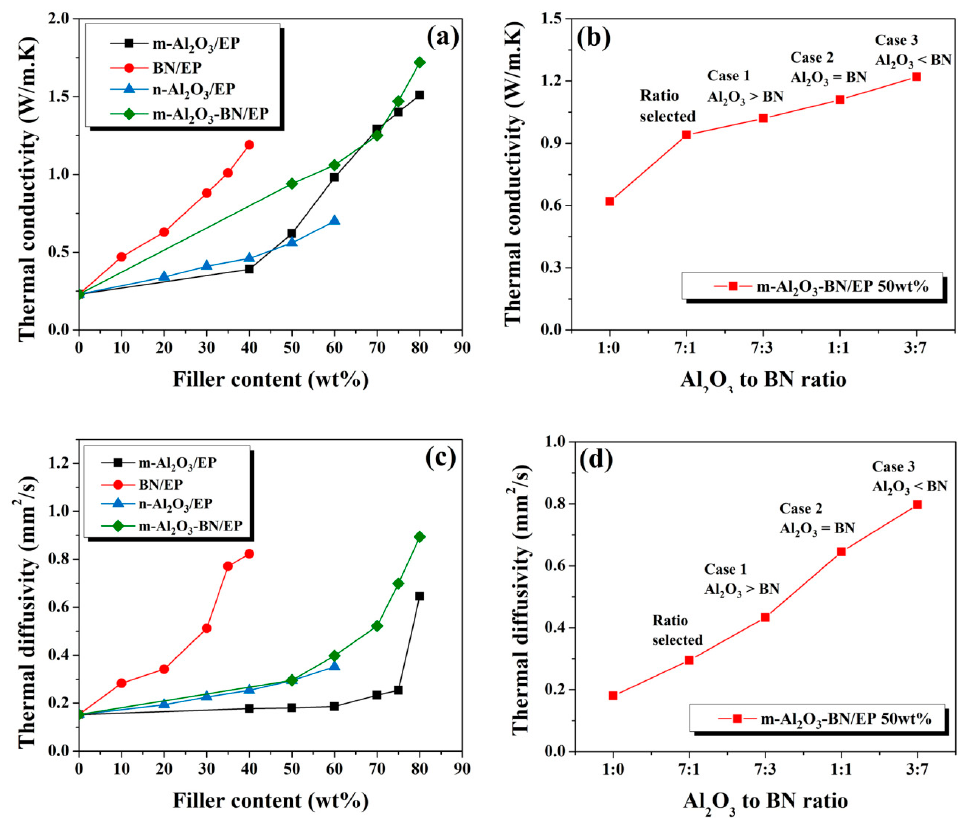
Polymers 2021 , 13 , x FOR PEER REVIEW 10 of 18